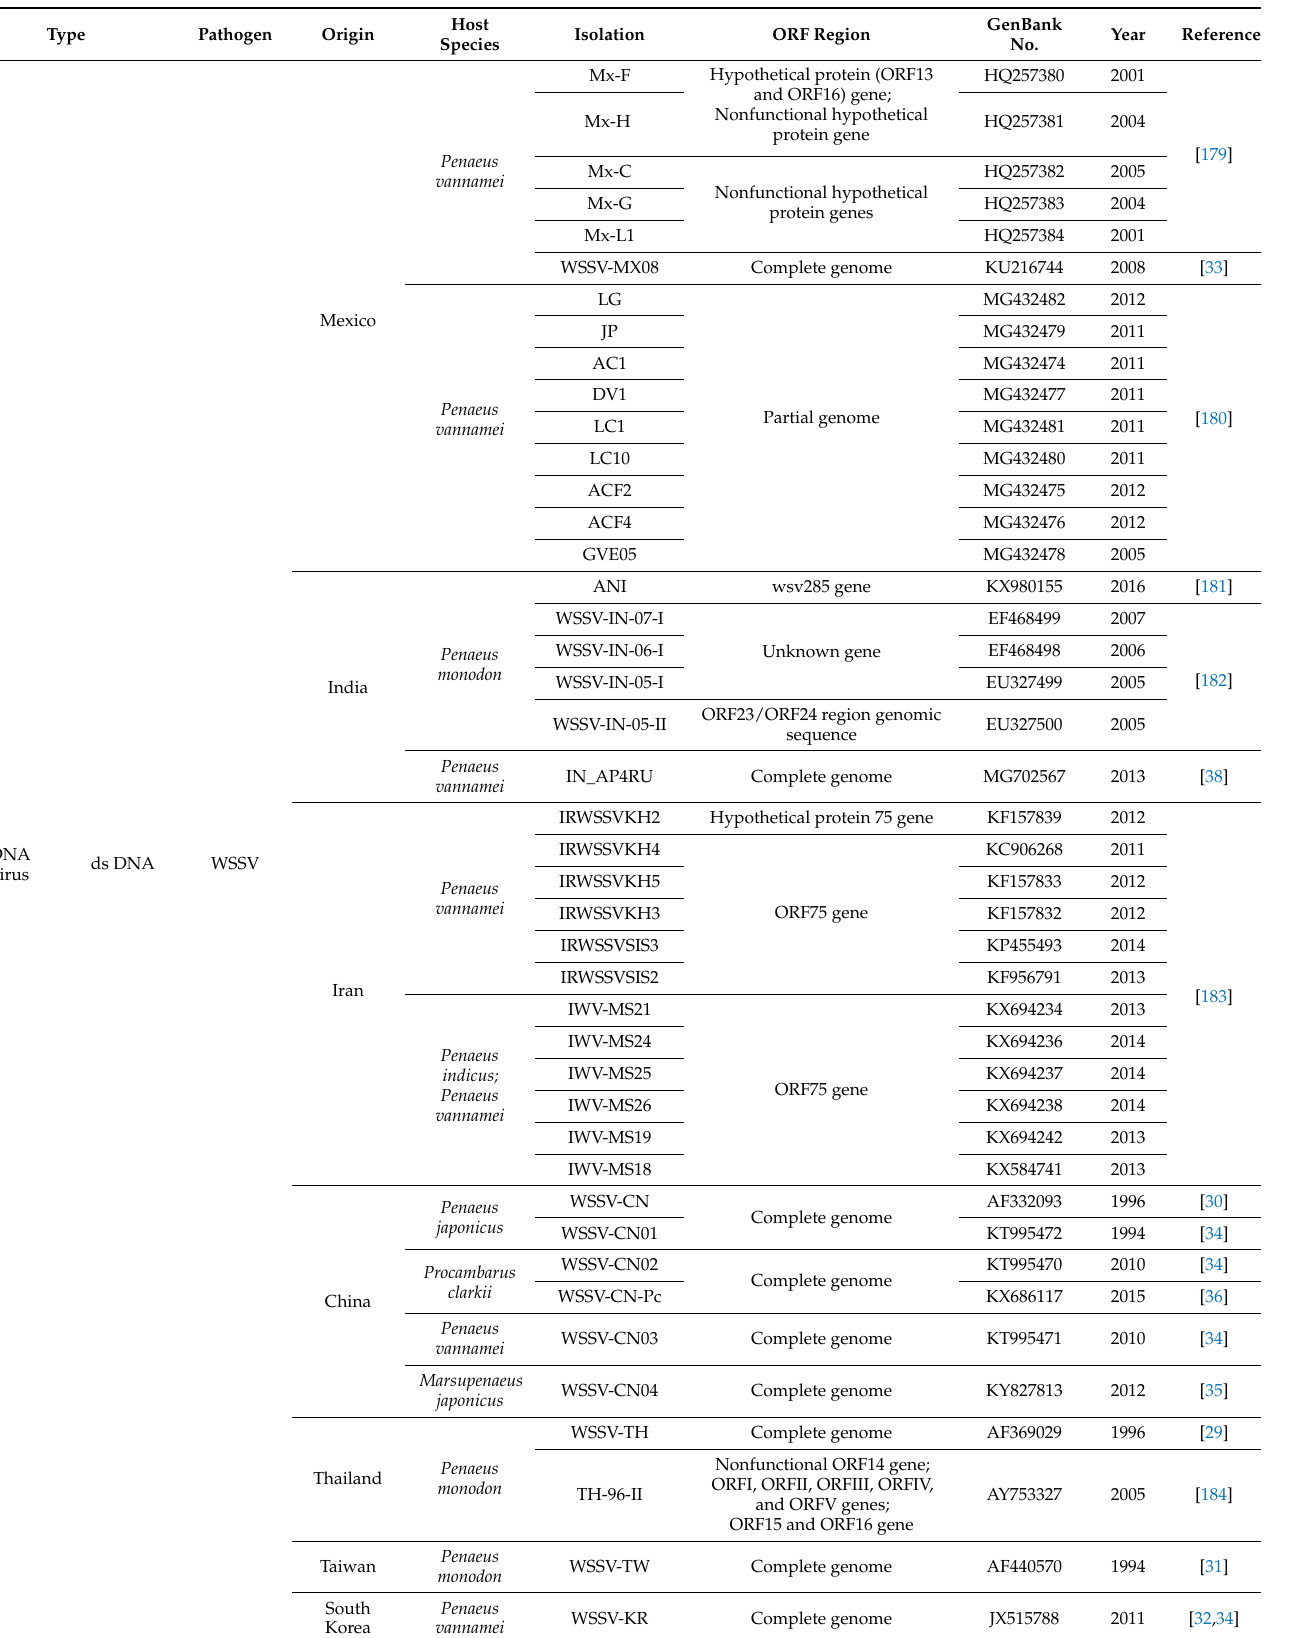
Table 3. Summary isolation and GenBank accession number information for the DNA and RNA viral disease